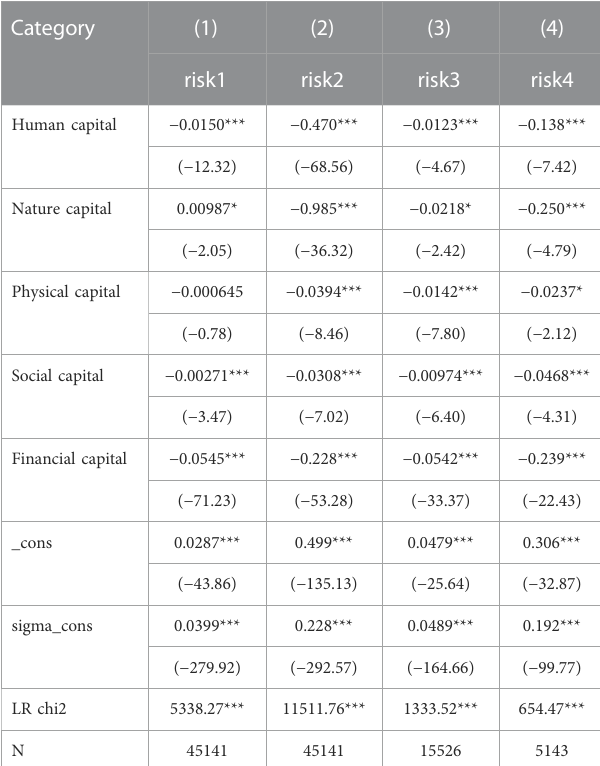
TABLE 4 Tobit regression estimates of aggregate livelihood capital to re- poverty risk a .